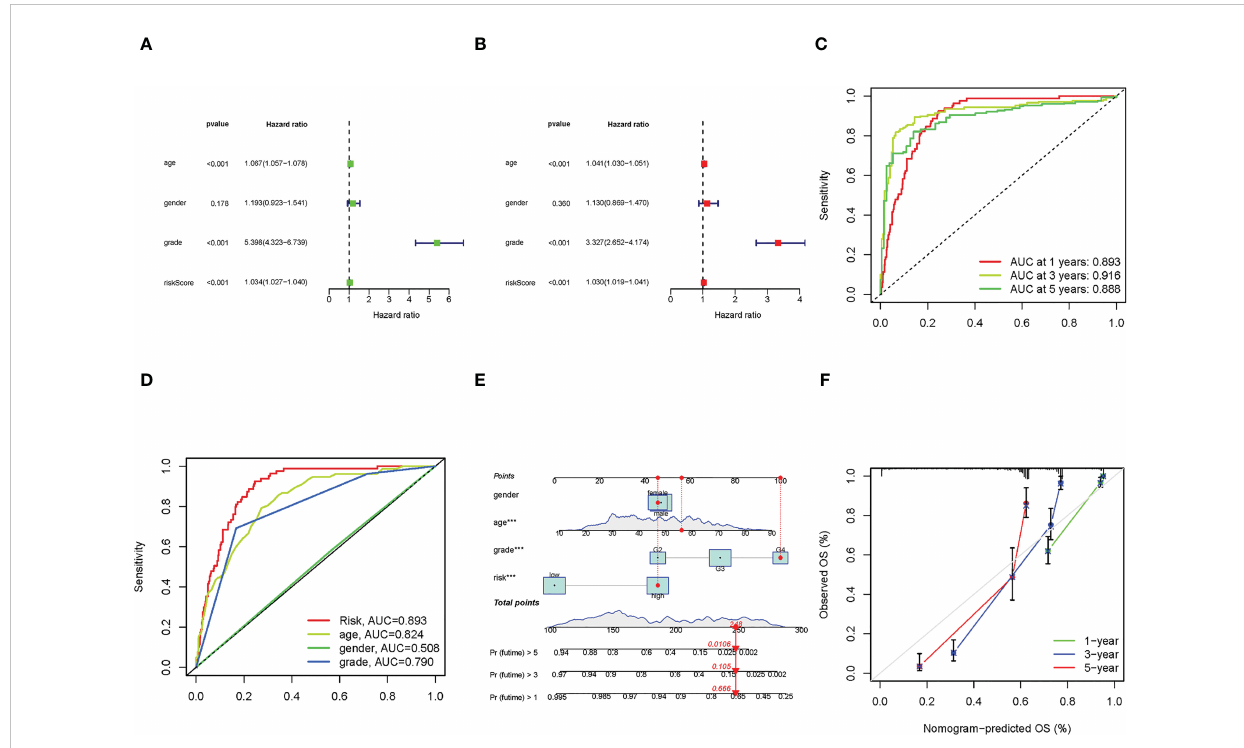
FIGURE 4 The construction of nomogram and assessment of the prognosis model. (A, B) The results of uni-Cox and multi-Cox analysis, respectively. (C) The risk score ’ s ROC curves of 1-, 3-, 5-year OS. (D) The ROC curves of risk score, age, gender, and tumor grade, respectively. (E) The nomogram that integrated the risk score, age, gender, and tumor grade predicted the probability of the 1-, 3-, and 5-year OS. (F) The calibration curves for 1-, 3-, and 5-year OS,